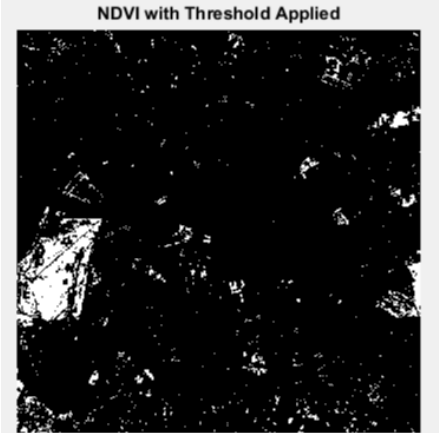
Figure 13. View of the analyzed terrain after using the Threshold